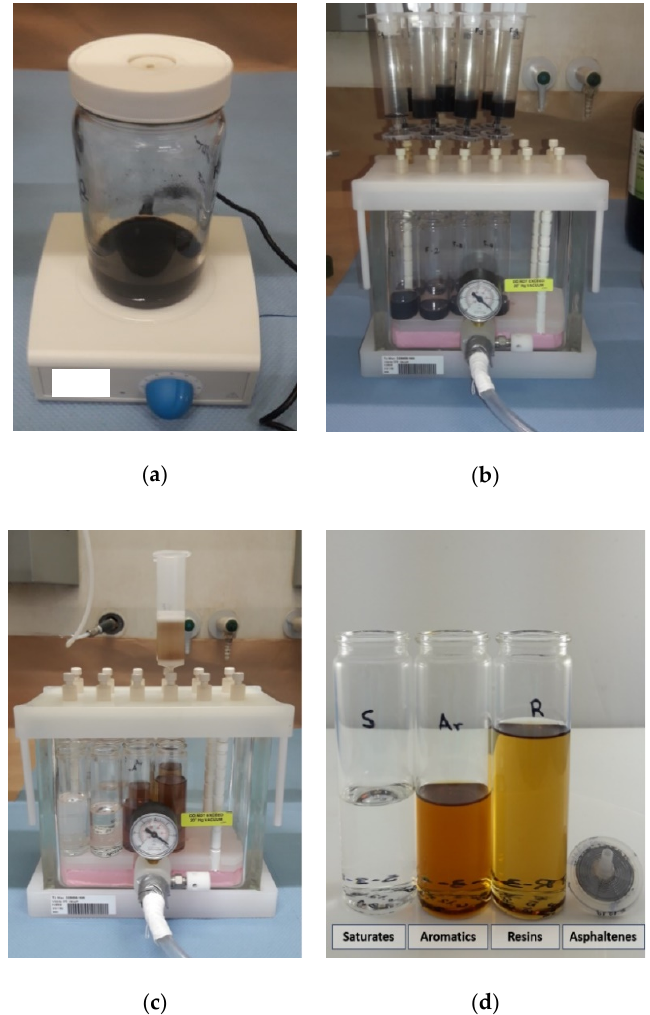
Figure 2. Saturates, Aromatics, Resins, and Asphaltenes (SARA) fractionation: ( a ) asphalt binder dissolution, ( b ) filtration of the solution, ( c ) maltene fractionation, and ( d ) SARA fractions.